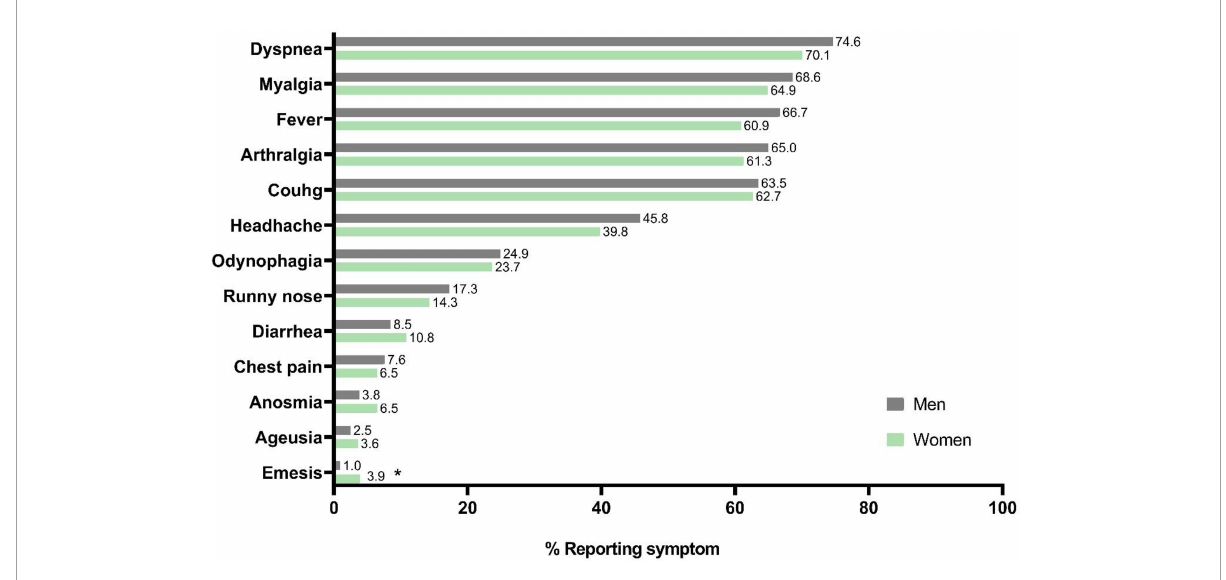
FIGURE1 Distribution of frequencies by gender to the symptomatology of COVID-19 in Mexican patients. Statistical analyses were performed by Chi-square test. Significance was set at p -value < 0.05. * p = 0.004.